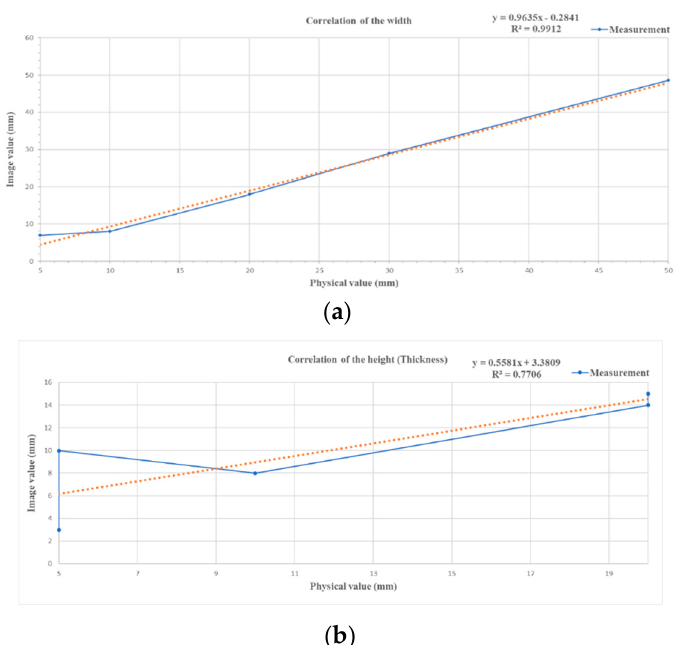
Figure 17. Correlation graph between the wear value of image and physical value: ( a ) width; ( b ) thickness.